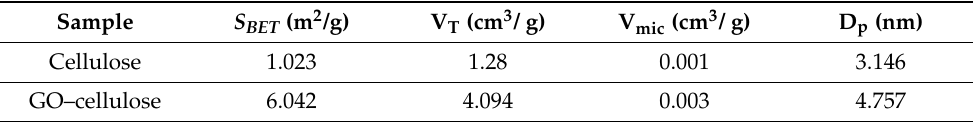
Table 2. Specific surface area and porous structure parameters of extracted cellulose and GO–cellu- lose composite .